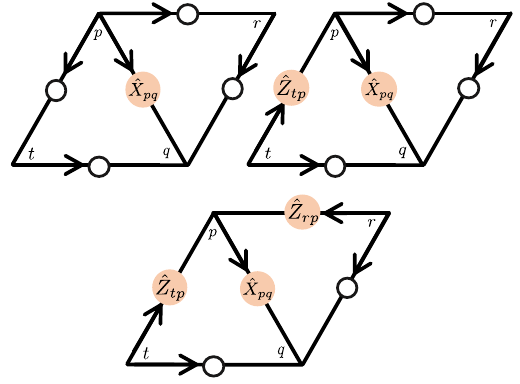
FIG. 8. The action of branching structure of the neighboring triangles. applied to h pq i , but a Pauli and second vertex of the neighboring triangle if and only if h pq i is the link connecting the second and third vertices of that